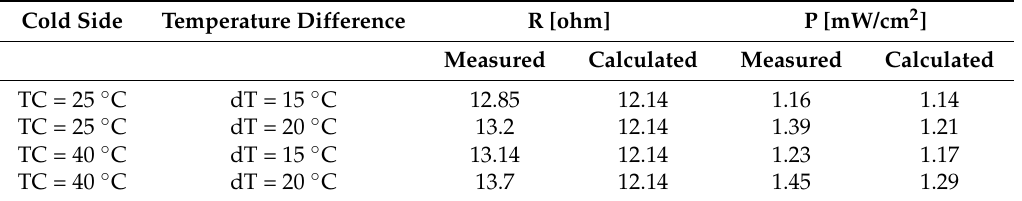
Table 4. Comparison between measured and calculated values of matched electrical load and respected output power.